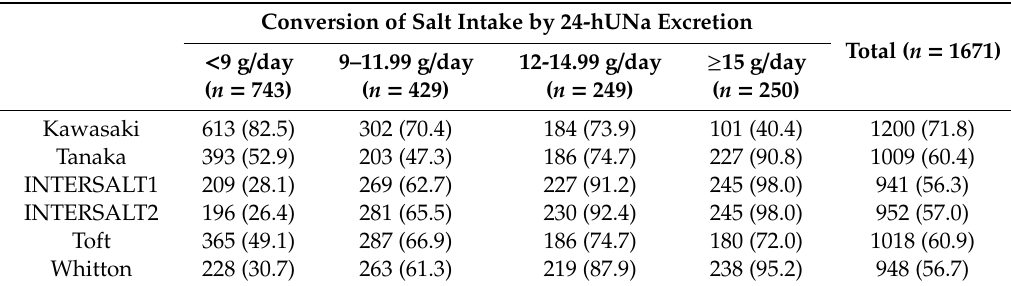
Table 3. Misclassification of the six predicted formulas at individual level, n